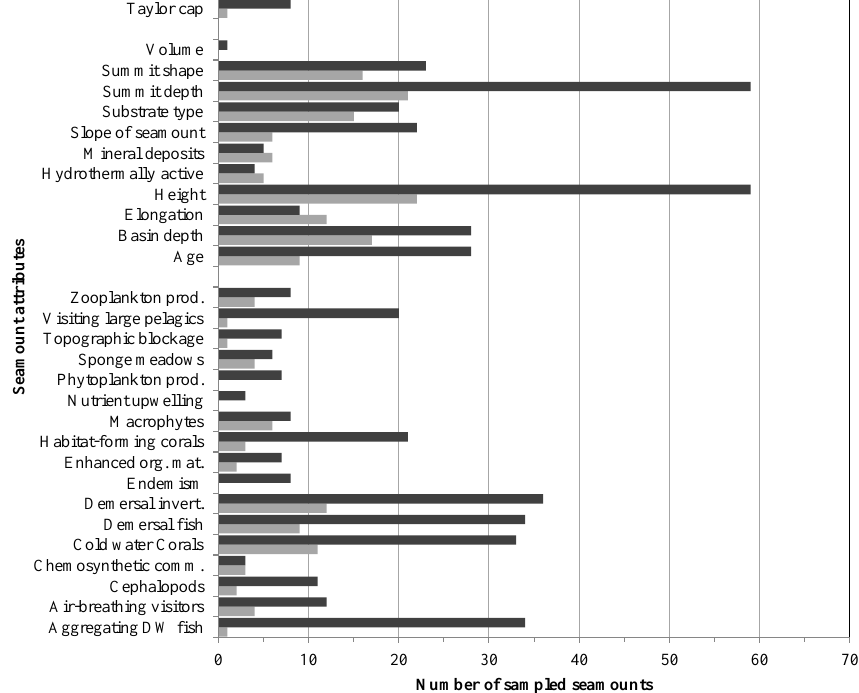
Fig. 9. Number of seamounts sampled for different attributes in the north-east Atlantic (dark grey) and in the Mediterranean Sea